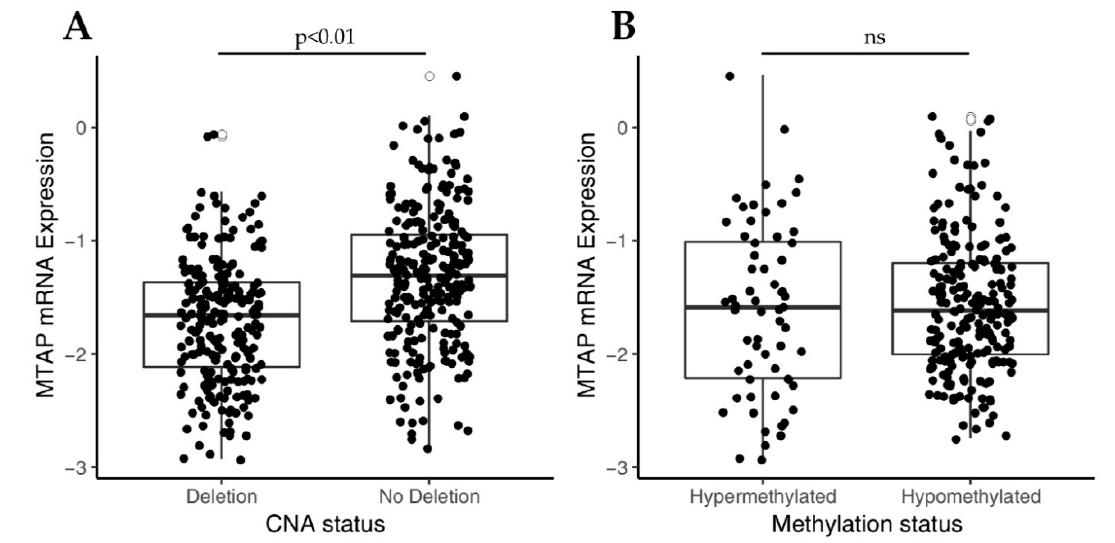
Figure 1. Analysis of MTAP mRNA expression in The Cancer Genome Atlas glioblastoma (TCGA-GBM) dataset correlates to copy number alterations (CNA) status for 9p21 locus and MTAP promoter methylation. ( A ) Box-plot analysis showing downregulation in MTAP expression in 9p21 homozygous deleted samples compared to matched normal samples ( p -value < 0.01). ( B ) Box-plot of MTAP expression and promoter methylation in TGCA-GBM dataset. ns : not significant p -value. Table 1. MTAP differential expression in subtypes of glioblastoma.